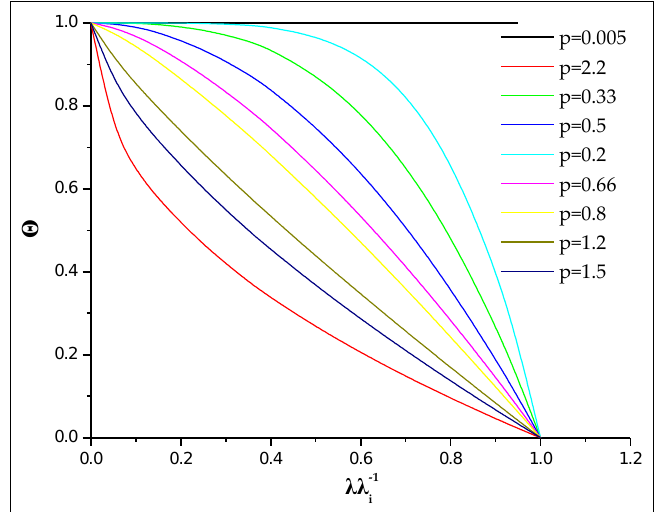
Figure 2. The relationship Θ( λ / λi ) for different values of the parameter p .